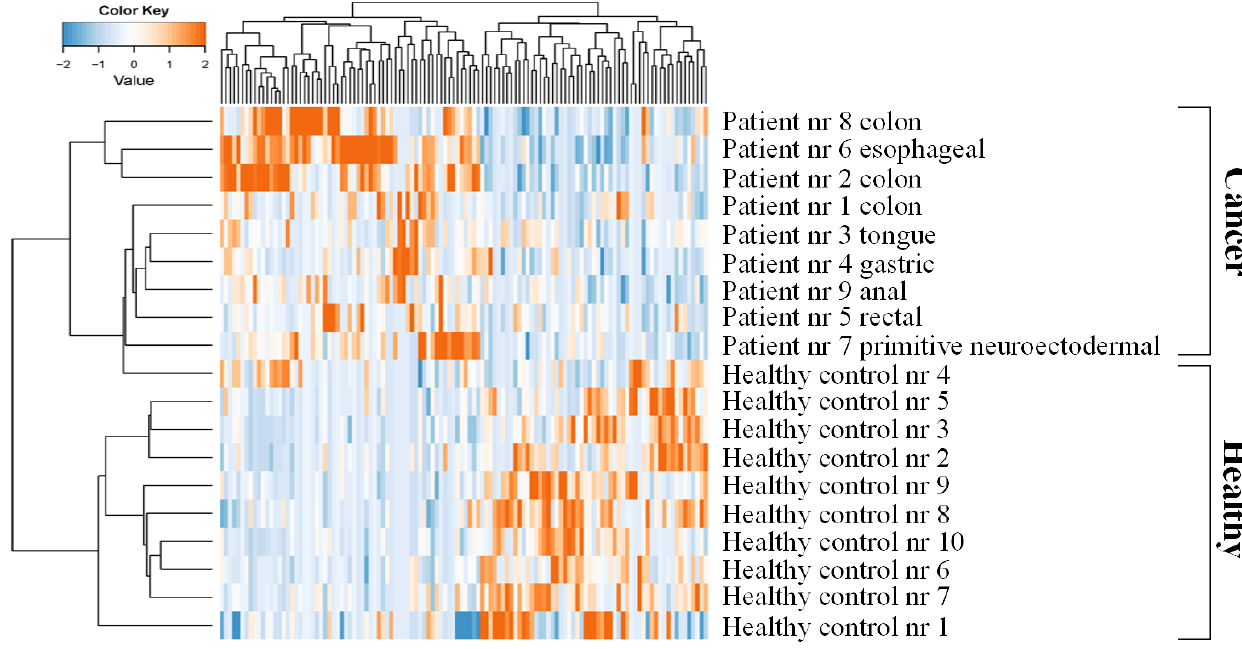
Figure 2. Platelet proteome profiling. Hierarchical clustering using proteins with differential abundance between platelets of patients with cancer ( n = 9) and healthy controls ( n = 10).